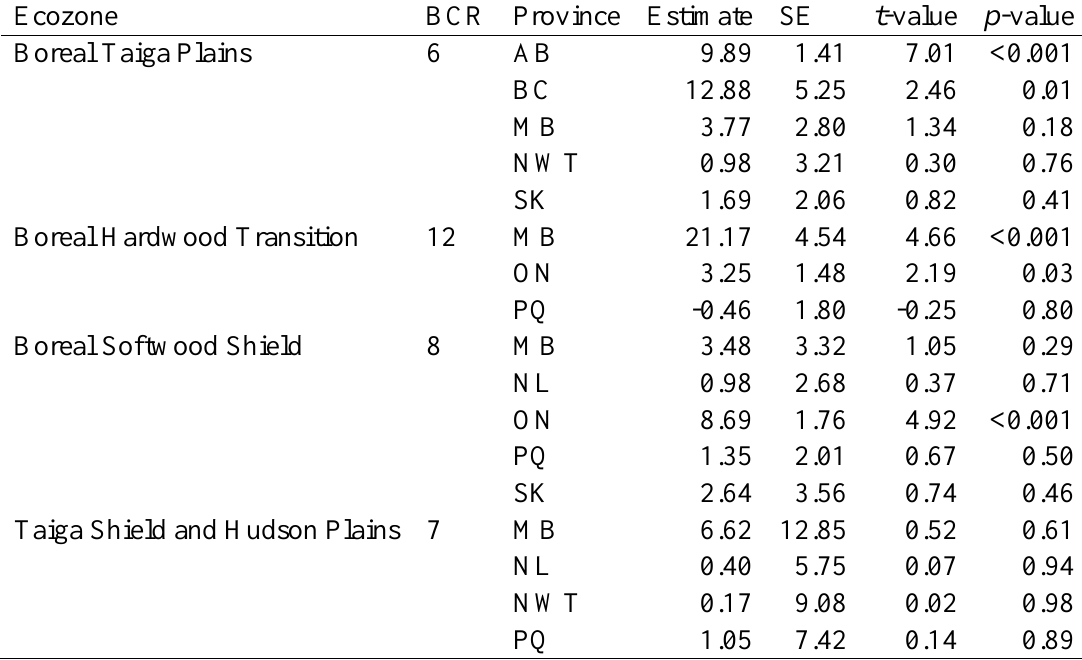
Table A1.3 Results of GAMM for bias in measurements of anthropogenic disturbance based